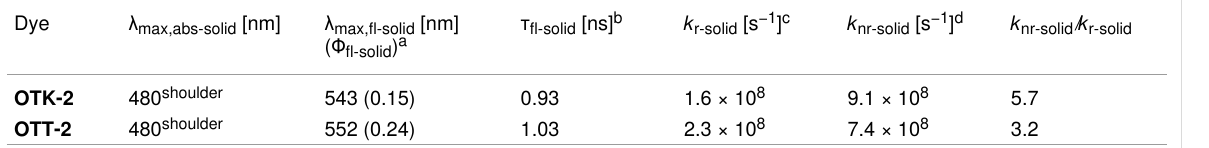
Table 2: Optical data of OTK-2 [33] and OTT-2 in the solid-state.